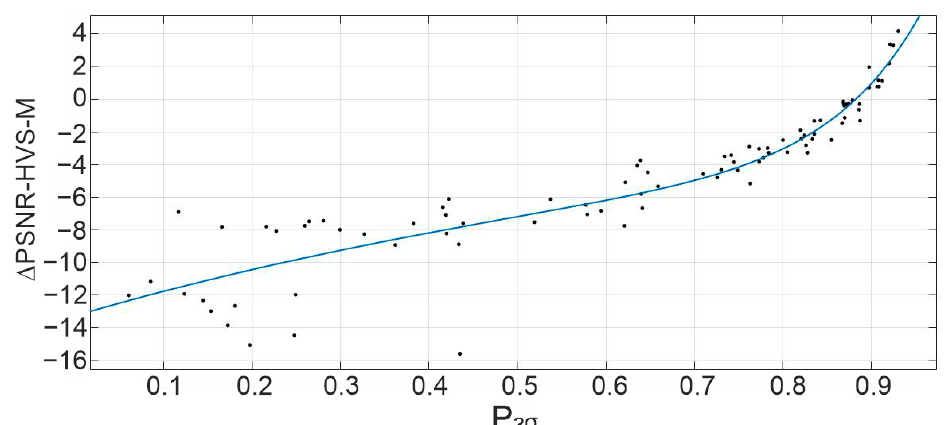
Figure 12. The scatter-plot ∆𝑃𝑆𝑁𝑅 vs. 𝑃 2𝜎 and the fitted curve of the model Fourier 3 (RMSE is about 0.42 and the R 2 and AdjR 2 are about 0.976).